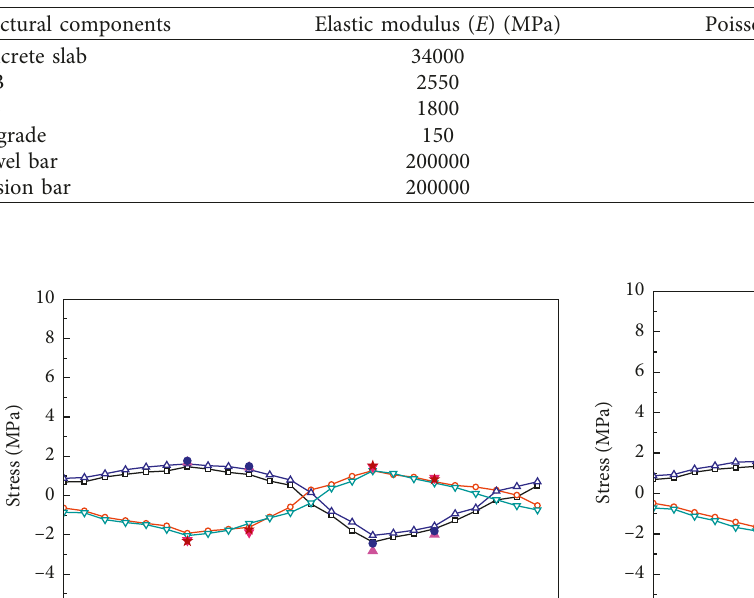
Table 3: Material properties used in numerical